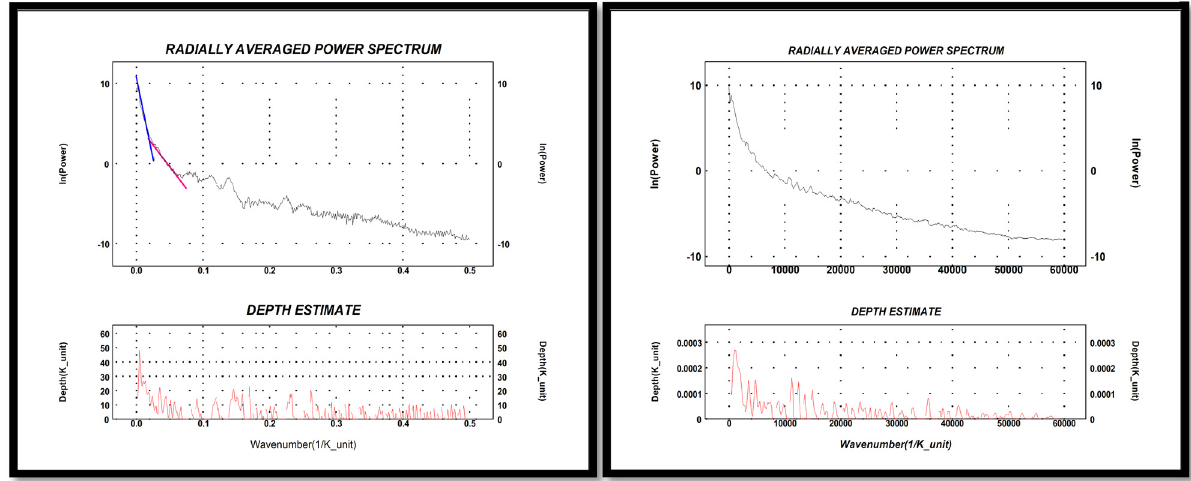
Figure 4: Power spectrum of magnetic and gravity anomaly maps.